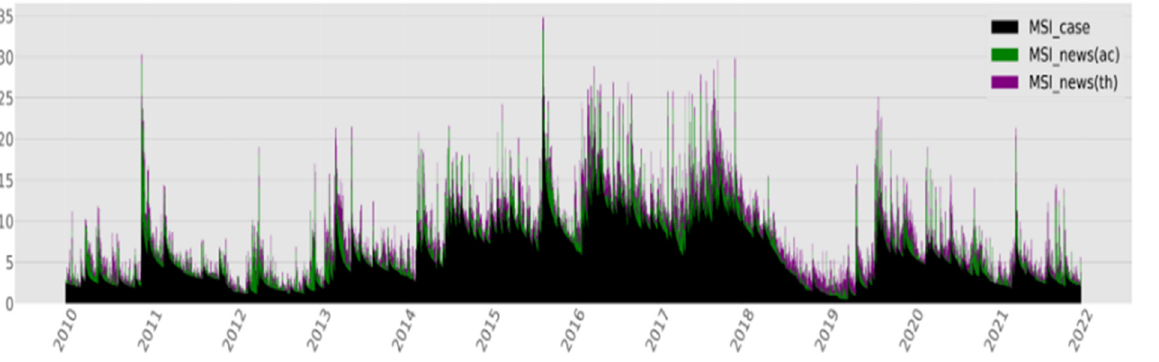
Figure 9. Military Security Index of North Korea (‘10 ∼ ’21).